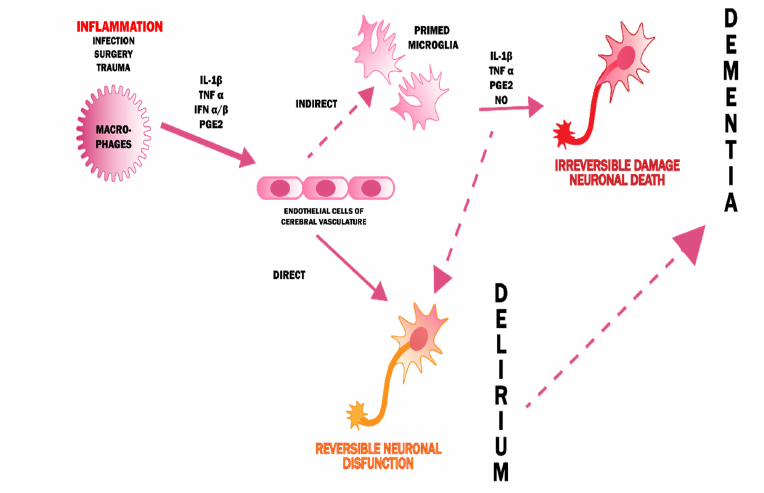
Figure 3. A possible pathogenesis of delirium, linking it with dementia [50].